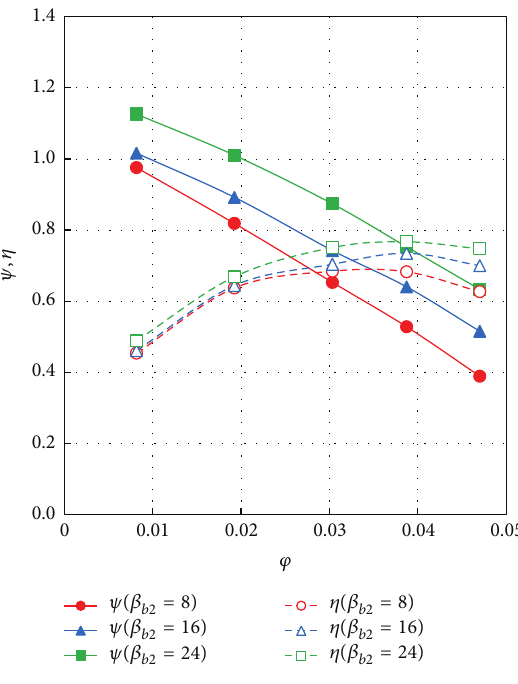
Figure 5: Performance